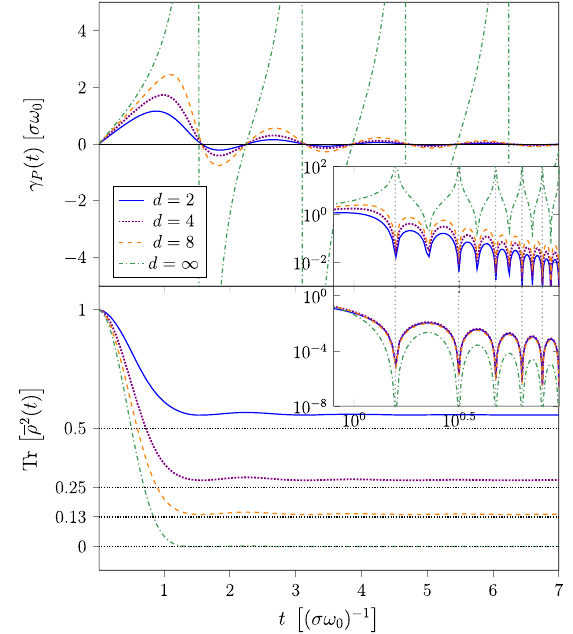
FIG. 3. Ensemble-average dynamics for the unitarily invariant Poissonian disorder ensemble. Top panel: Depolarization rates γ t Þ [cf. Eq. (77)] for dimensions d ¼ 2 ; 4 ; 8 ; ∞ . Inset: Double- P ð t Þj , showing the ongoing oscillations logarithmic plot of j γ P ð combined with an algebraic decay to zero for finite dimensions d ¼ 2 , 4, 8. Bottom panel: Decay of the purity Tr ½ ¯ ρ 2 ð t Þ(cid:2) of a pure initial state with Tr ½ ρ 2 ð 0 Þ(cid:2) ¼ 1 . For finite dimensions, the purity does not asymptotically drop to the maximally mixed value 1 =d (indicated by horizontal, black, dotted lines); see also Eq. (80). Inset: Double-logarithmic plot of the approach to the asymptotic purity j Tr ½ ¯ ρ ð t Þ 2 (cid:2) − lim t → ∞ Tr ½ ¯ ρ ð t Þ 2 (cid:2)j , showing that the purity oscillations are directly correlated with the oscillations of the t Þ around zero. We chose the uniform box distribution rate γ P ð width σ ¼ 4 for comparison with the GUE as in Ref.